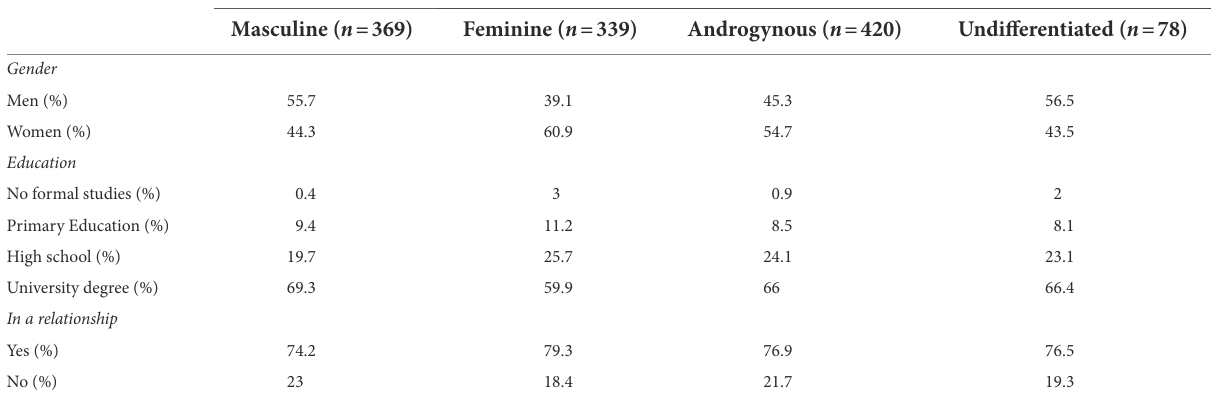
TABLE 2 Sociodemographic characteristics of the sample according to gender